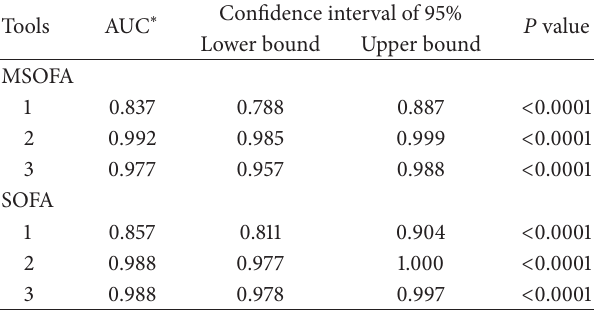
Table 3: Comparison of predictive power of SOFA 1, SOFA 2, and SOFA 3 and MSOFA 1, MSOFA 2, and MSOFA 3, in predicting